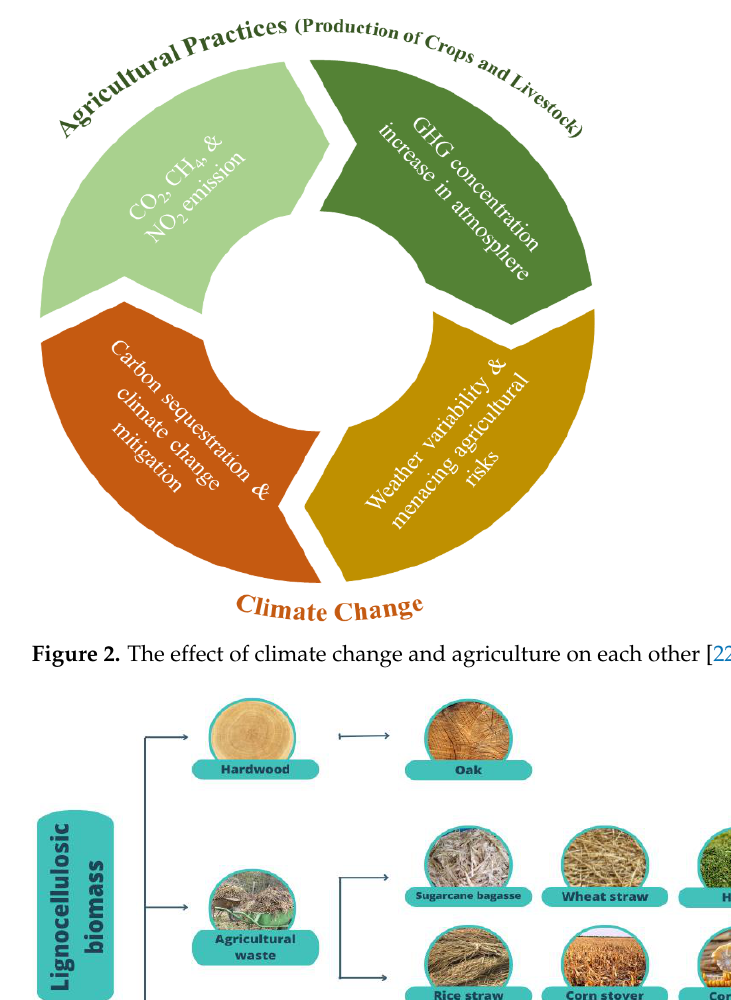
Figure 2. The effect of climate change and agriculture on each other [22] .